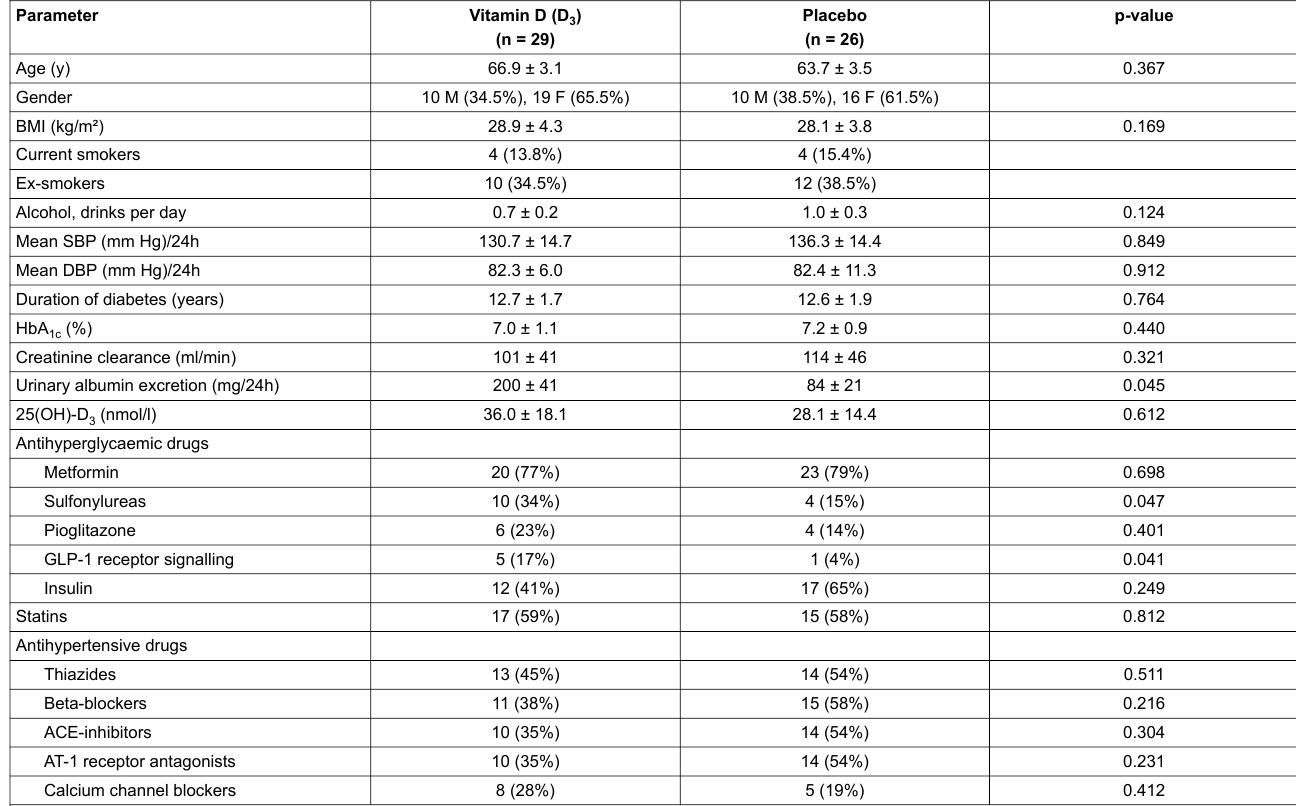
Table 1: Baseline characteristics of the participants, according to the study groups (mean ± standard deviation).